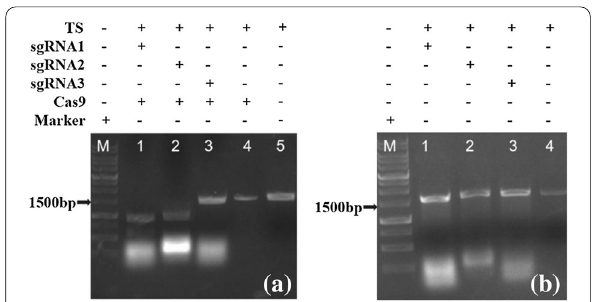
Fig. 2 Analysis of sgRNA cleavage activity for target DNA. a Cleavage results of three sgRNA-Cas9 complexes to target DNA. b Cleavage results of single three sgRNAs to target DNA. TS: PCR products of target DNA; sgRNA: transcribed RNAs in vitro; Cas9: Cas9 protein; The plus represents the component in reaction system. shows no this component in reaction